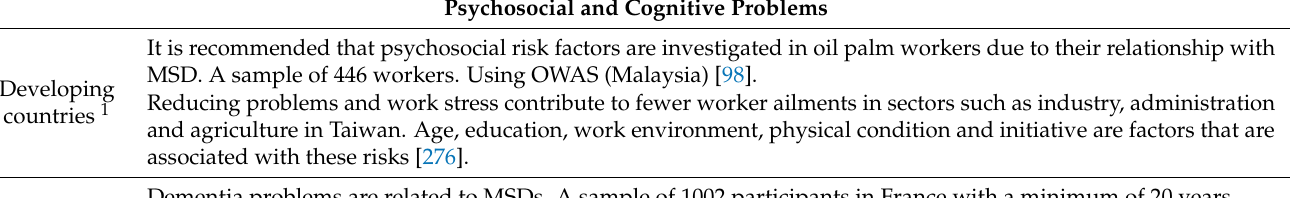
Table A12. MSD research in agriculture (1995–2020). Category: Psychosocial and cognitive problems. Psychosocial and Cognitive Problems